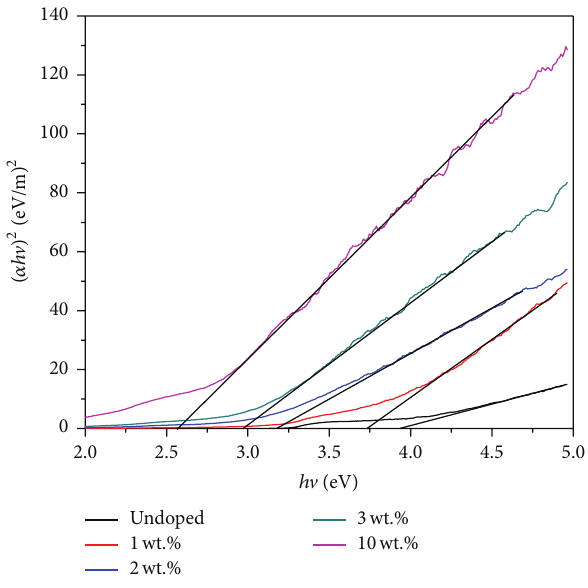
Figure 5: Plot of (𝛼ℎ V ) 2 versus photon energy (ℎ V ) .